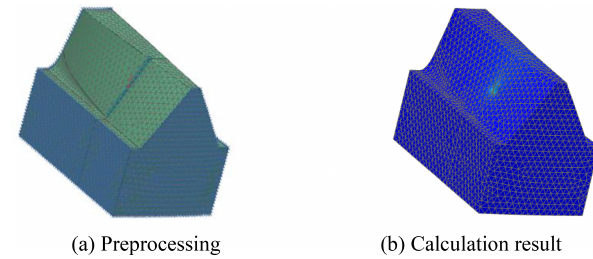
Figure 6. Finite element model of a single tooth of the NFG.